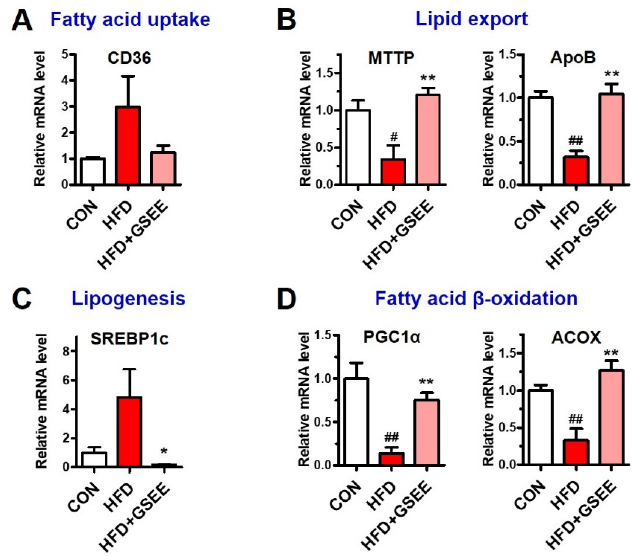
Figure 6. Effects of GSEE on the expression of genes involved in lipid metabolism in HFD-fed mouse livers: ( A ) relative CD36 mRNA levels representing fatty acid uptake; ( B ) microsomal triglyceride transfer protein (MTTP) and apolipoprotein B (ApoB) mRNA levels representing lipid export; ( C ) sterol regulatory element-binding protein-1c (SREBP1c) mRNA level representing de novo lipogenesis; ( D ) peroxisome proliferator-activated receptor- γ , coactivator-1 α (PGC1 α ) and acyl-CoA oxidase (ACOX) mRNA levels representing fatty acid β -oxidation. Mice were fed with HFD for 10 weeks with or without daily oral administration of GSEE (45 mg/kg of body weight). Liver samples from randomly selected 4 mice in each group were used for qRT-PCR. Values are represented as mean ± SE. Student’s t -Test, #, ## p < 0.05 and 0.01, respectively, vs. control. *, ** p < 0.05, and 0.01, respectively, vs. HFD.